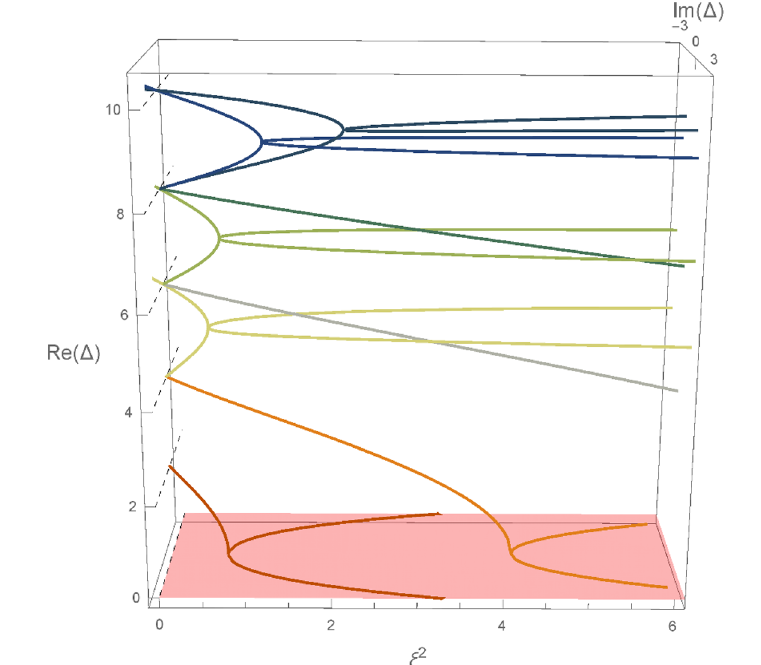
Figure 20 . Some states with (cid:1)(0) = 4 ; 6 ; 8 ; 10 for J = 1 ; M = 1 with (cid:18) 1 = 11 = 4 and (cid:18) 2 = 9 = 4, S 1 = S 2 = 0. The number of states and weak coupling expansions again match the predictions in section 5, however, for this choice of angles the spectrum is qualitatively di(cid:11)erent. As for the case of (cid:12)gure 19, exactly one level, for any given (cid:1)(0) = 2 n , reaches a branch point with (cid:1) c = 0, and then splits into a pair of imaginary levels which show classical behaviour at strong coupling. All other states merge in pairs at branch points with (cid:1) c 6 = 0. After these branch points, they split into two complex conjugate levels with a nonzero real part, which appear to tend to constant values at strong